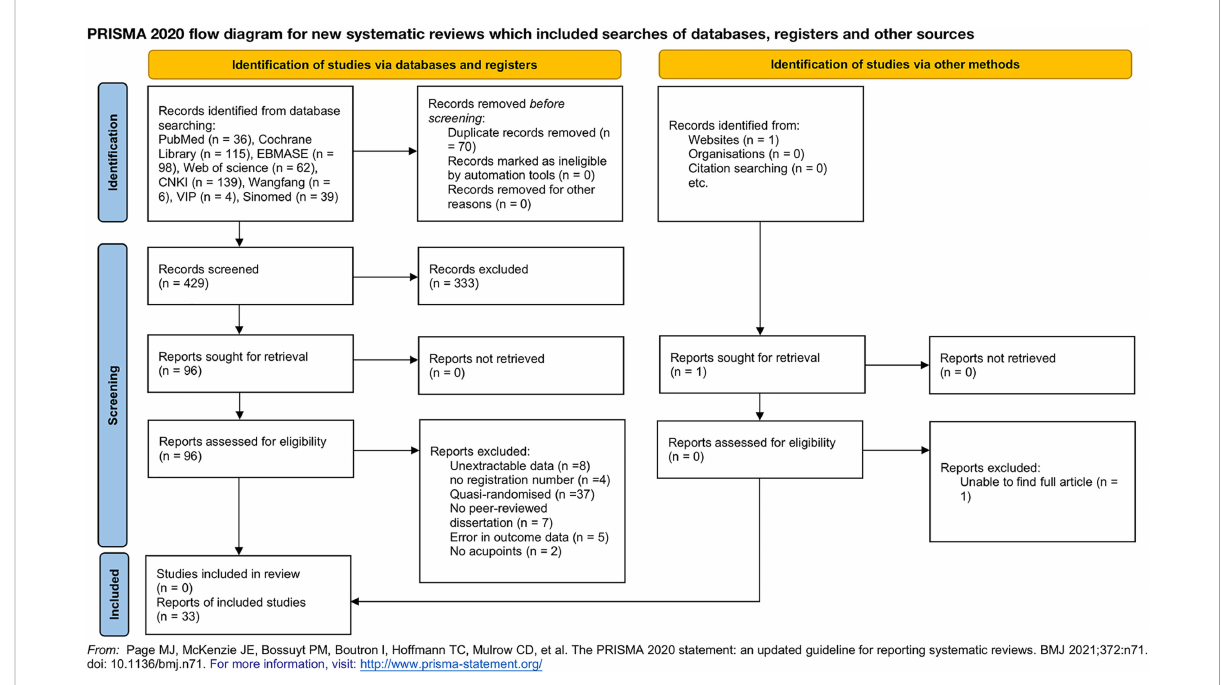
FIGURE 1 Preferred Reporting Items for Systematic Review and Meta-Analyses (PRISMA) 2020 fl ow diagram for new systematic reviews that included the searches of databases, registers, and other sources. From: Page MJ, McKenzie JE, Bossuyt PM, Boutron I, Hoffmann TC, Mulrow CD, et al.